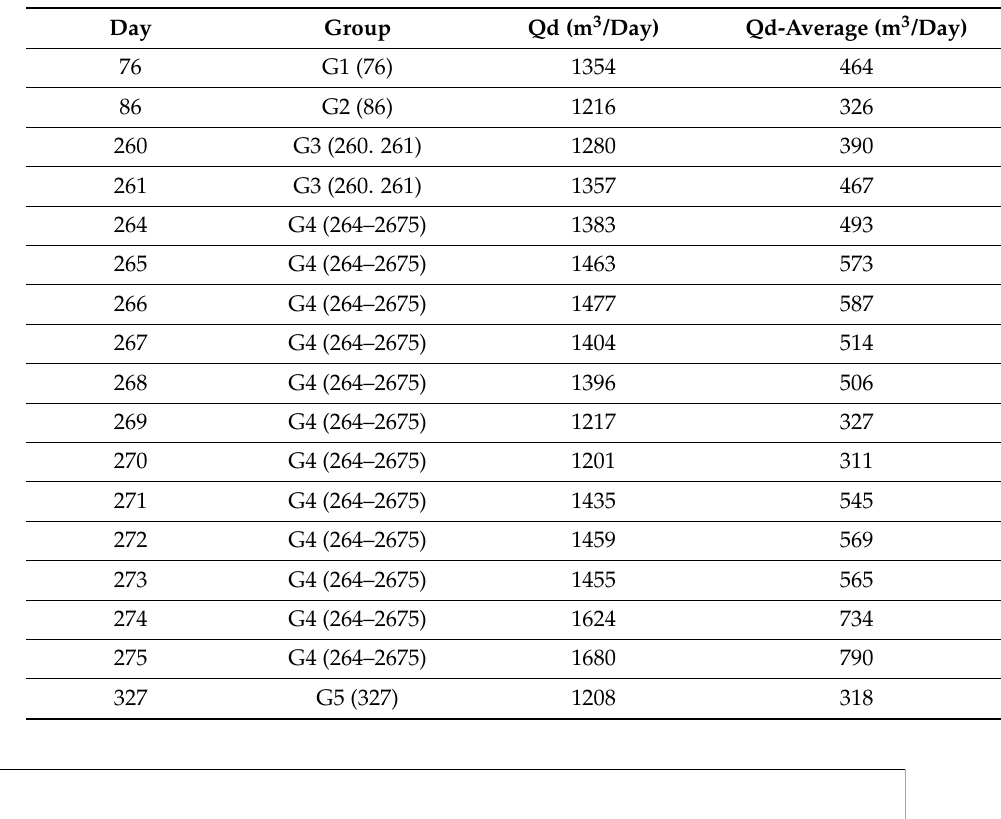
Table 11. Leak events in the water distribution of the scientific campus.